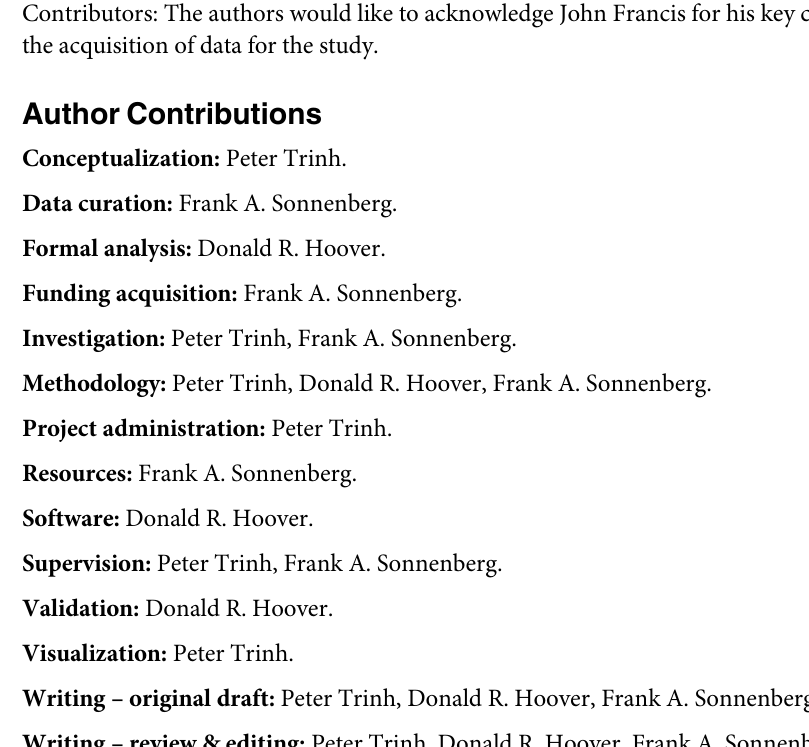
S1 Table. Differences in median number of laboratory tests ordered. S2 Table. Differences in median number of diagnoses